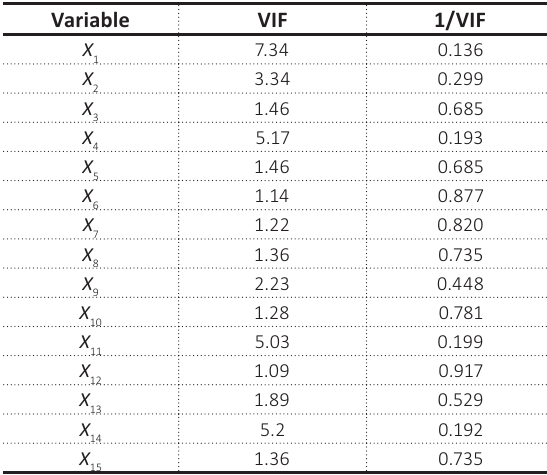
Table 4. Variance inflation factor (VIF)